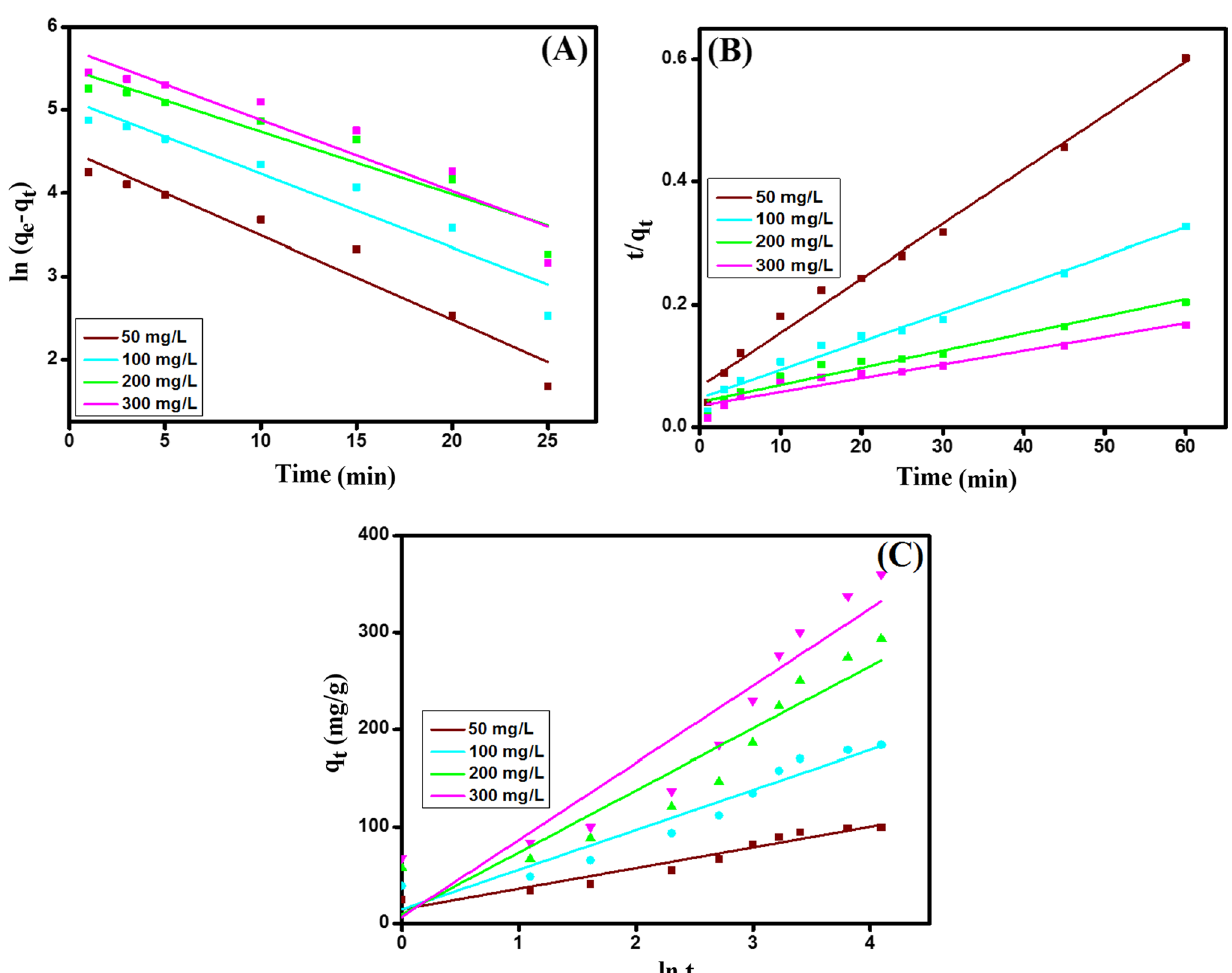
Fig. 5 Kinetic study; A Pseudo-first-order, B Pseudo-second-order, and C